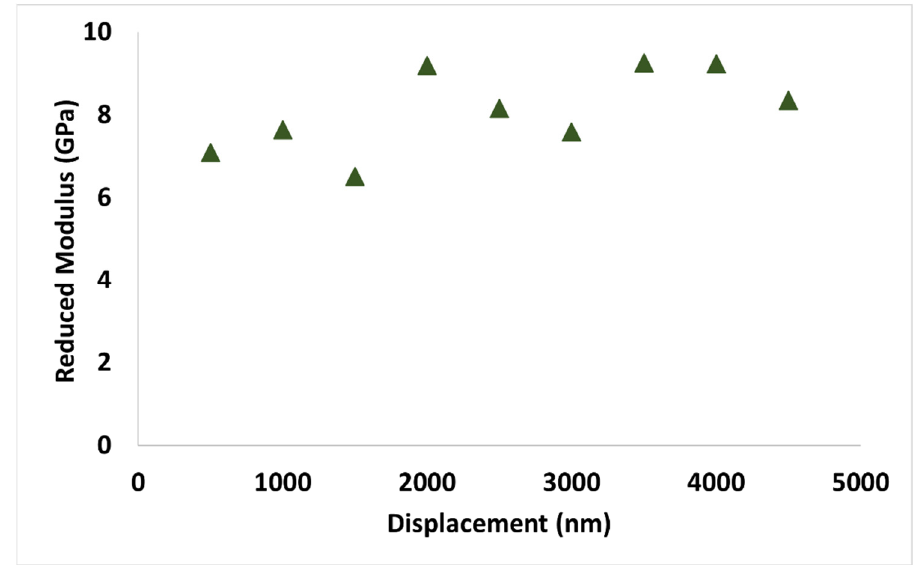
Figure 7. Reduced modulus value measured on nanocomposite coating using nanoindentation.